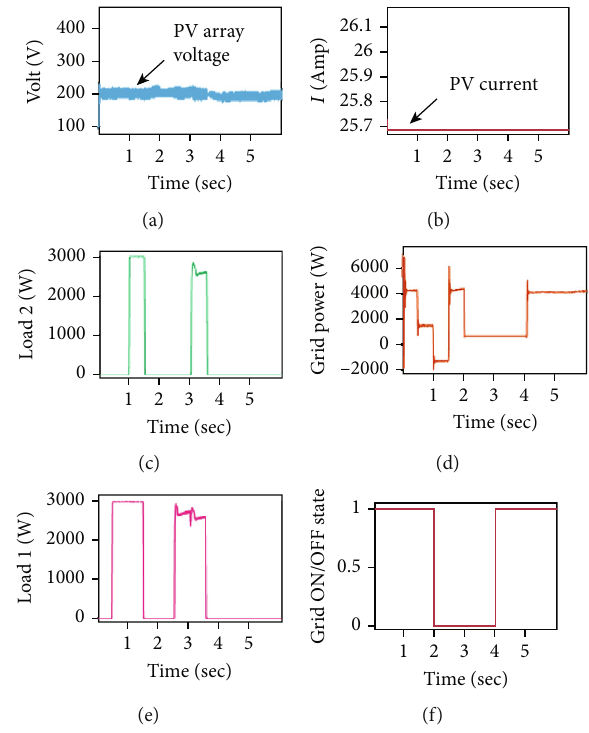
Figure 6: Load, grid, and solar photovoltaic